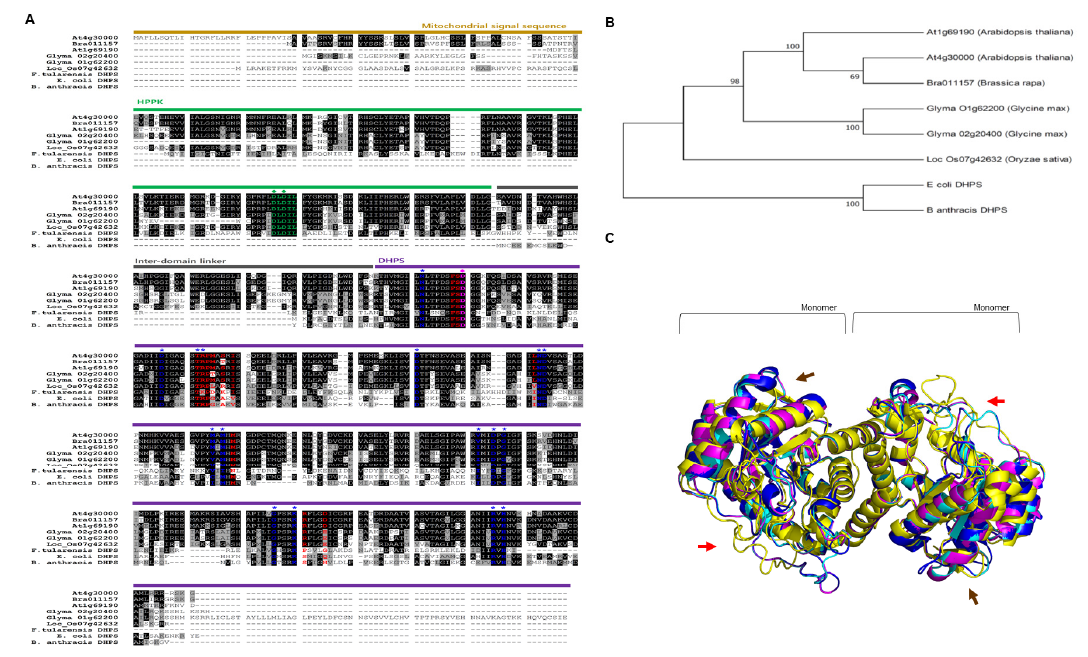
Figure 3. The structural relevance of DHPS enzymes from di ff erent species. ( A ) The primary structure of the DHPS enzyme. The DHPS sequences were retrieved from GenBank; At ( Arabidopsis thaliana ), Bra ( Brassica campestris ), Glyma ( Glycine max ), Loc_Os ( Oryza sativa ), F. tularensis , E. coli , and B. anthracis using Clustal W. Blue and red residues are substrate-binding and sulfonamide-resistance residues, respectively. Strictly conserved amino acids are black, and similar residues are gray. Yellow: Mitochondrial signal sequence, green: HPPK domain, gray: inter-domain linker, purple: DHPS domain. ( B ) The phylogenetic relationship of bacterial DHPS ( E. coli and B. anthracis ) and plant DHPS ( Arabidopsis thaliana , Brassica campestris , Glycine max , and Oryza sativa ). All deduced amino acid sequences were compared within a phylogenetic tree by a neighbor joining method (Mega7). ( C ) The structural superposition of EcDHPS (PDB code 5U10, yellow), Bra011157 (cyan), Loc_Os07g42632 (blue), and Glyma 02g20400 (magenta). Next, we further compared the primary structure of DHPS using three representative genes: B. campestris HPPK-DHPS (BcHPPK-DHPS), F. tularensis HPPK-DHPS (FtHPPK-DHPS), and E. coli DHPS (EcDHPS). The results indicate that BcHPPK-DHPS (Bra011157) is a functional ortholog exhibiting high similarity and identity; 37.9% identity and 58.9% similarity were observed between EcDHPS and FtHPPK-DHPS, which are both catalytically active enzymes in in vivo and in vitro experiments [28,29]. Theoretically, BcHPPK-DHPS exhibits 43.9% identity and 65.6% similarity with EcDHPS [30,31] and 37.02% identity and 61.4% similarity with FtHPPK-DHPS. These results suggest that the bifunctional HPPK-DHPS enzymes, including B. campestris DHPS (Bra 011157), are active enzymes with very similar three-dimensional (3D) structure. In addition, bifunctional HPPK-DHPS is likely a genetically evolved form of the monofunctional DHPS enzyme because two sequential enzymatic reactions in a single polypeptide can be more substrate-specific and more rapid by not detecting intermediate products. Given that sulfa-DHP is synthesized by sulfonamides serving as an alternative substrate of DHPS (Figures 1B and 2), sulfa-DHP structurally presents as an analog of dihydropteroate (DHP).